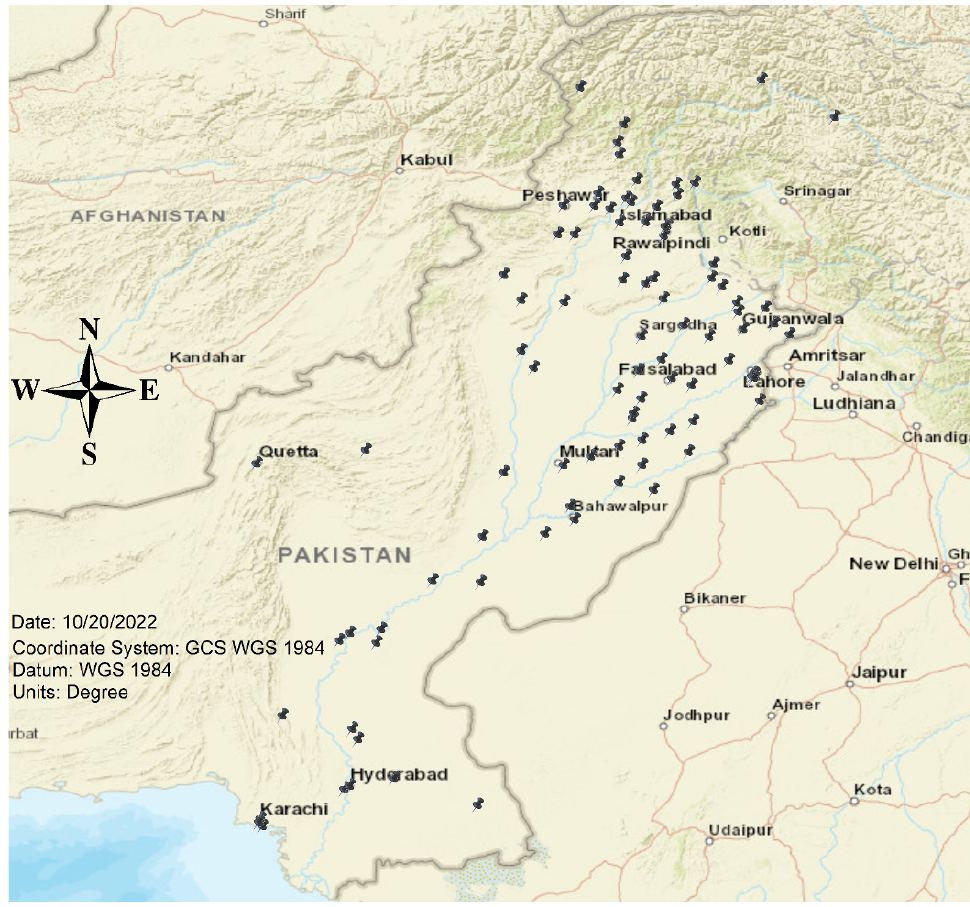
Figure 9. Visualization of city-level tweets’ information over Pakistan’s base map using